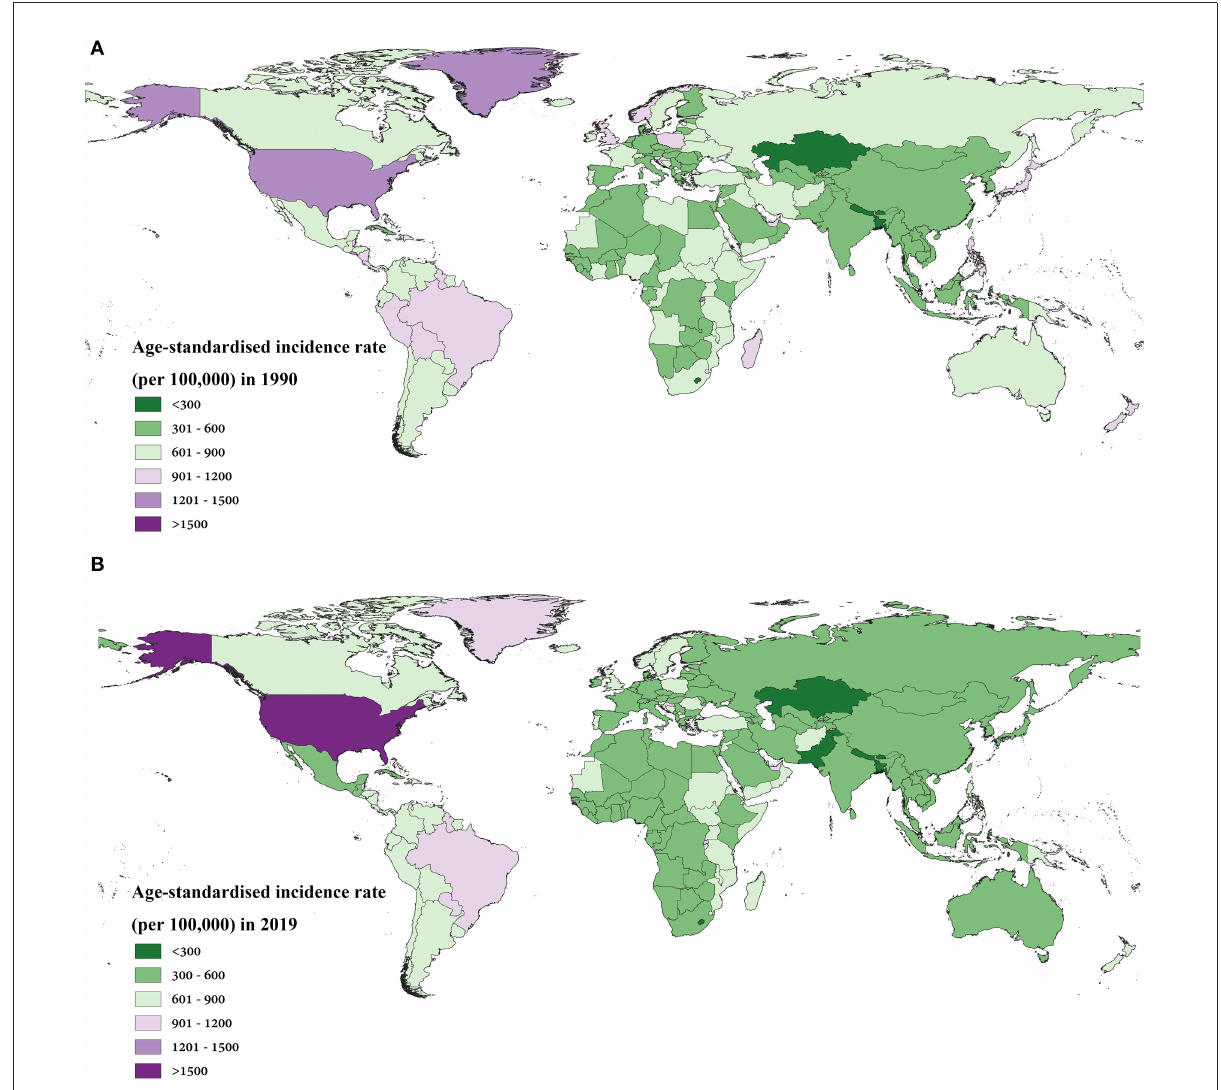
FIGURE3 The age-standardised incidence rate in 1990 (A) and 2019 (B) for asthma in 204 countries and territories